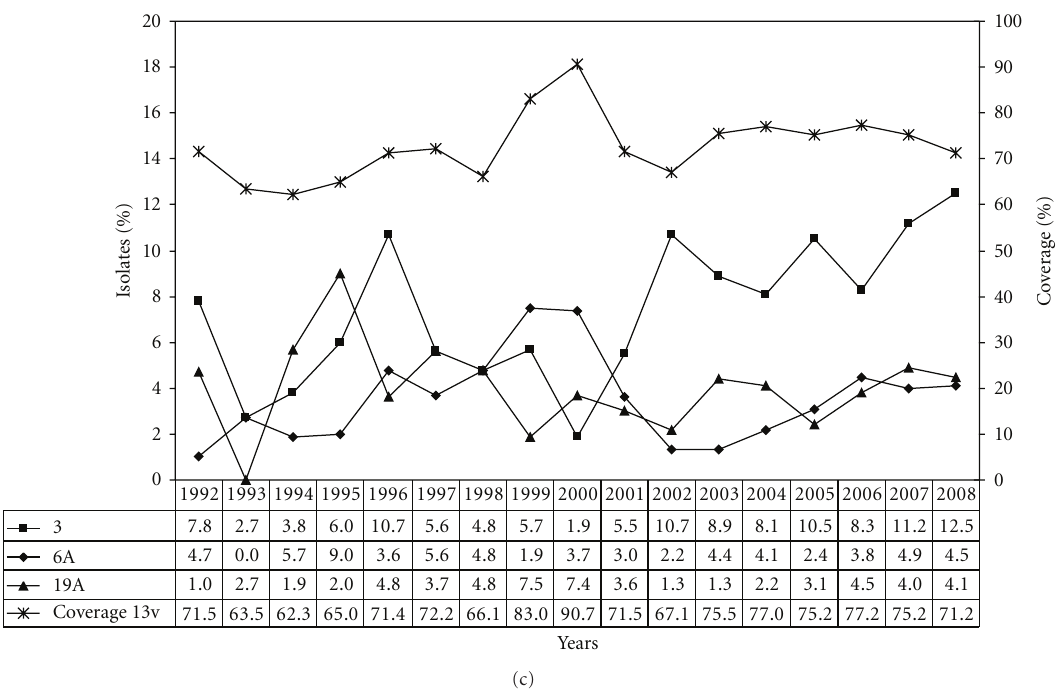
Figure 4: (a) Distribution of the additional 13v-pneumococcal conjugate vaccine serotypes 3, 6A, and 19A and the 13-valent vaccine coverage in percent (1992–2008, n = 9,394). (b) Distribution of the additional 13v-pneumococcal conjugate vaccine serotypes 3, 6A, and 19A and the 13-valent vaccine coverage among children in percent (1992–2008, n = 2,948). (c) Distribution of the additional 13v-pneumococcal conjugate vaccine serotypes 3, 6A, and 19A and the 13-valent vaccine coverage among adults in percent (1992–2008, n = 6,446).